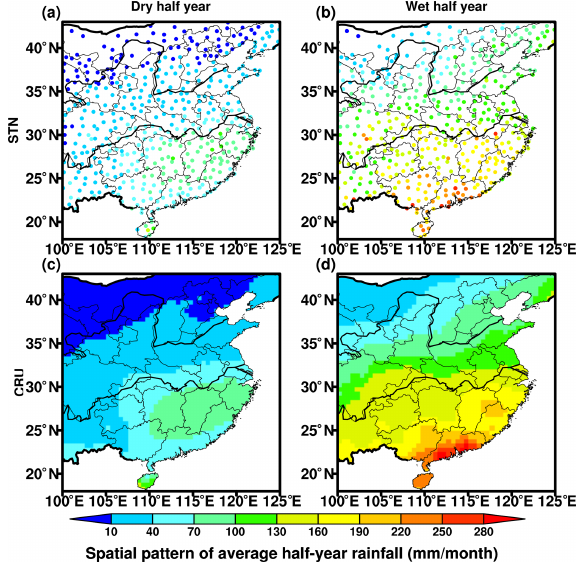
Figure 2. Spatial distribution of seasonal mean precipitation (mm/month) from 1960–2015 over eastern China from the obser- vation and CRU datasets. Panels (a) and (c) are for the dry season; panels (b) and (d) are for the wet season.